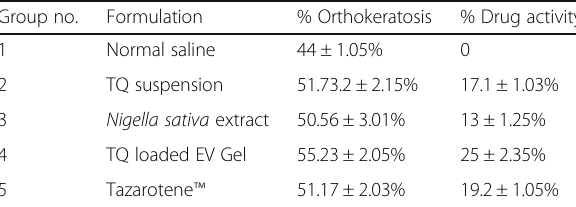
Table 4 % Drug activity of different formulations (Mean ± SD) Group no.